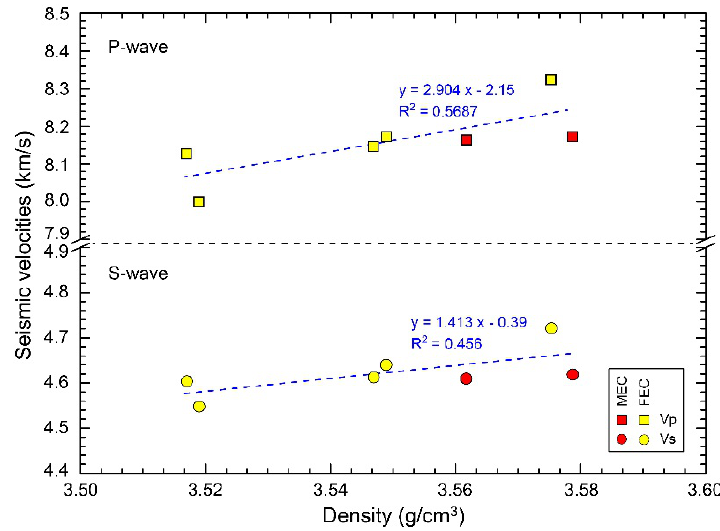
Figure 12. Relations between the bulk rock averaged seismic velocities (Vp and Vs) and density.